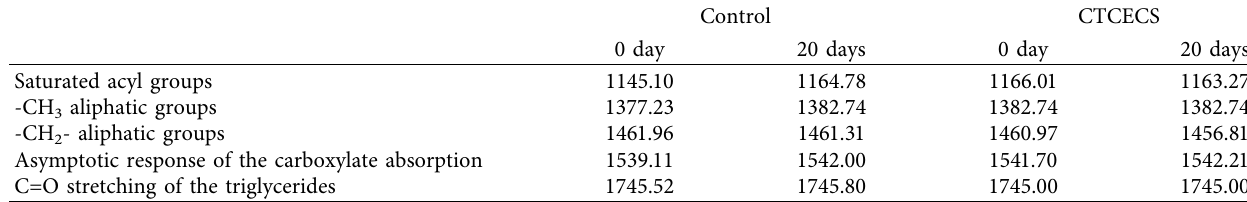
Table 5: FTIR peak assignments of different